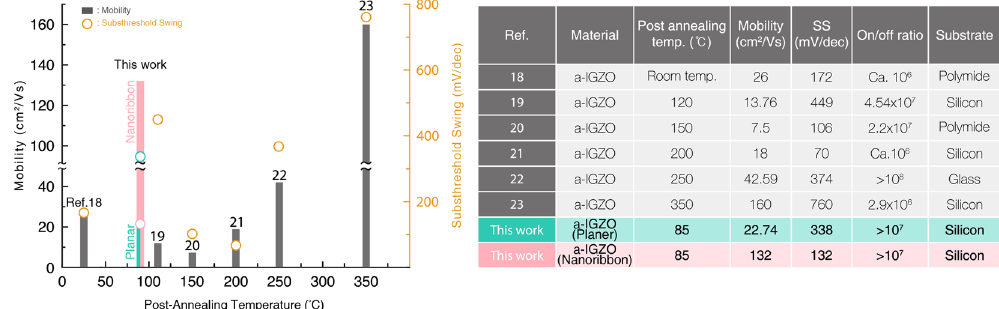
Figure 1. Recent progress in AOS-based thin-film transistors (TFTs). Post-annealing temperature versus mobility and Subthreshold swing (SS) achieved in recent studies into a-IGZO TFTs. A summary of detailed device specifications and substrates is shown in the table. The nanoribbon material shows the optimal combination of low temperature, high mobility, and low subthreshold